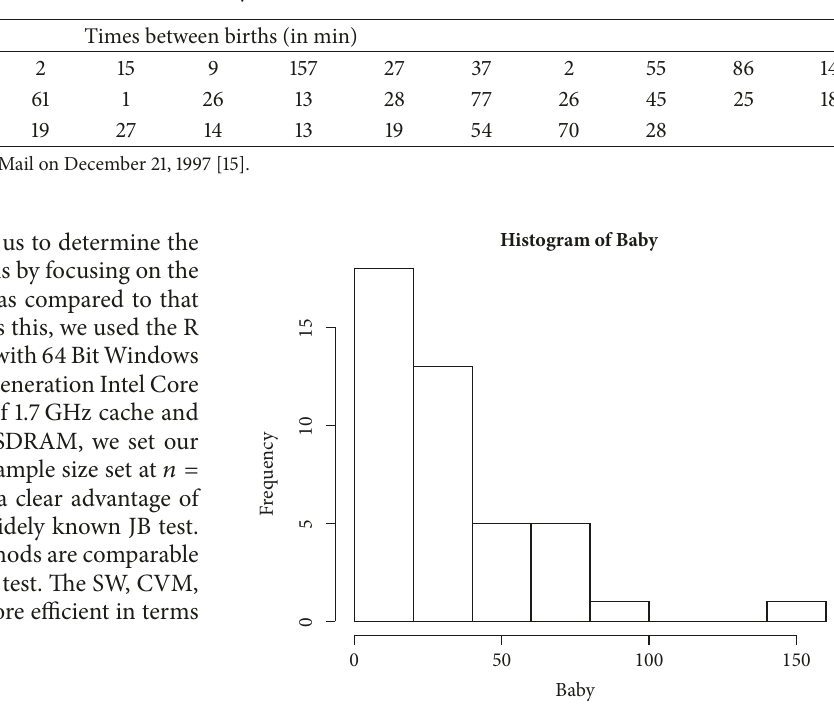
Table 2: The baby boom data.